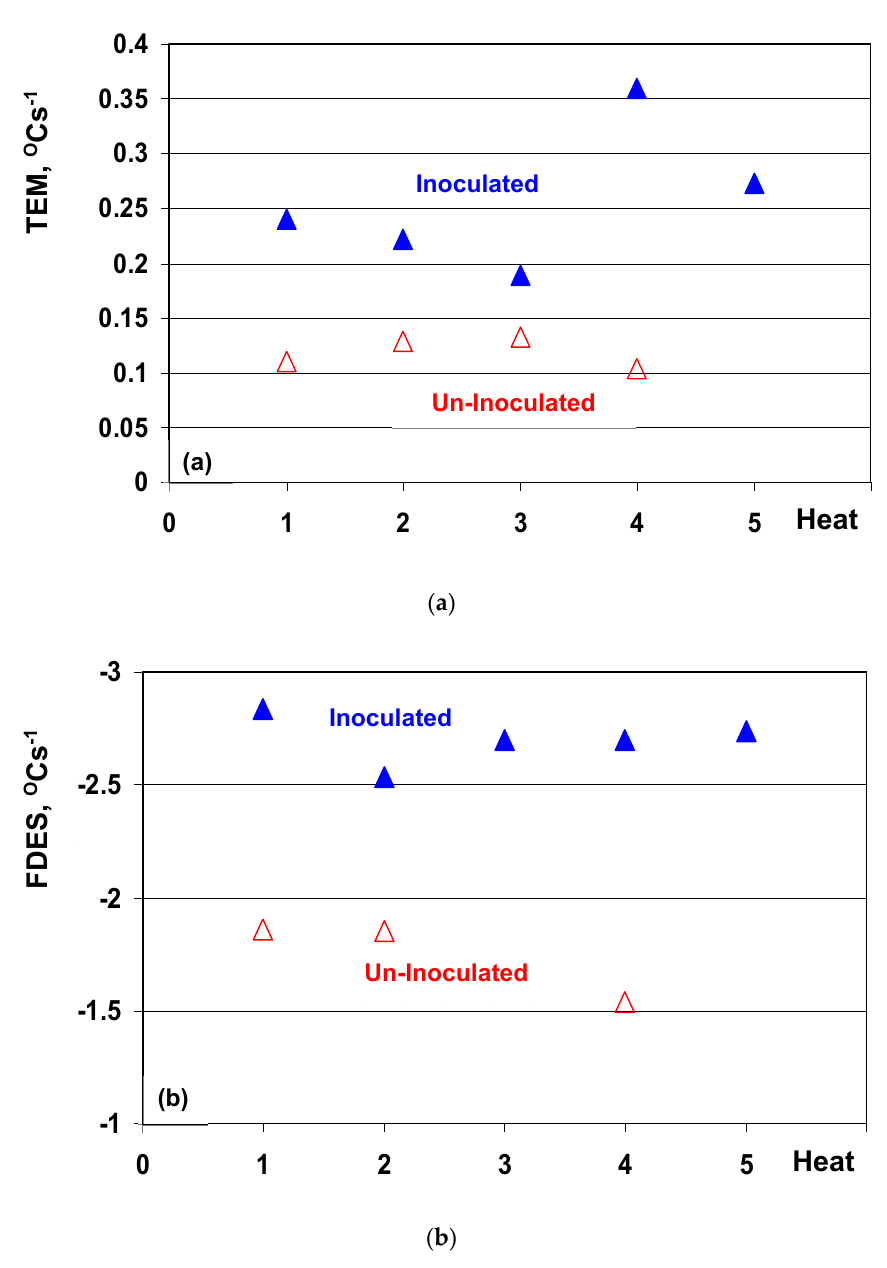
Figure 7. Maximum recalescence rate (TEM) ( a ) and the value of the first derivative of the cooling rate at the end of solidification (FDES) ( b ) of un-and-inoculated grey cast irons.